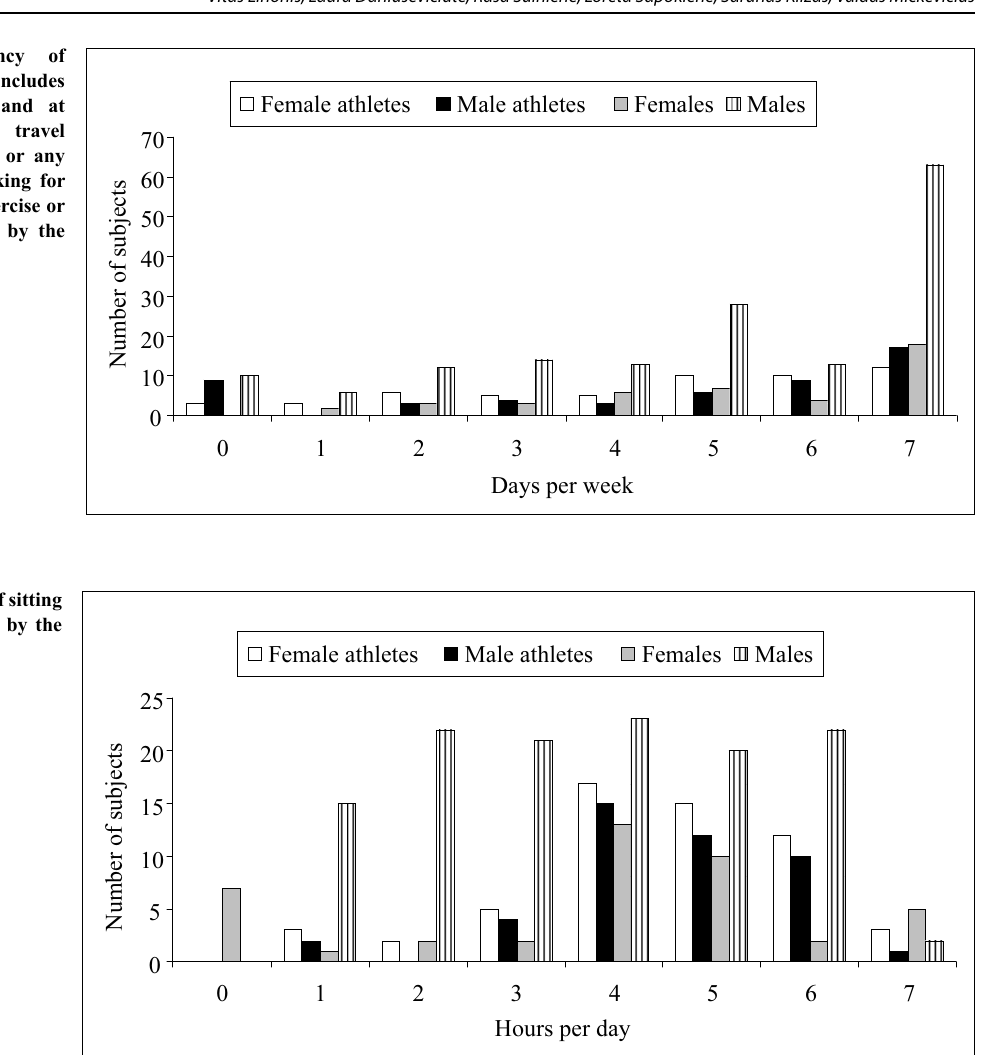
Figure 4. The hours of sitting per day as indicated by the subjects